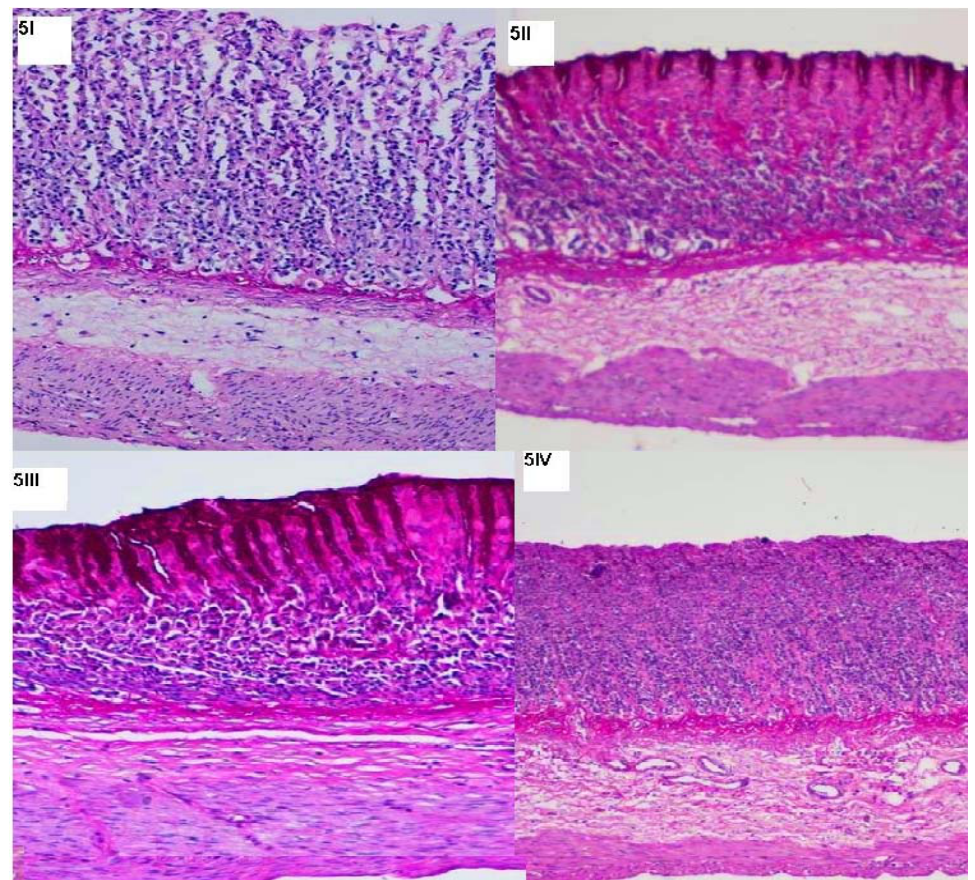
Figure 5. Effect of CuLBS on gastric tissue glycogen-PAS staining. Stomach subjected to ethanol-induced ulcer after treatment with CMC ( 5I ); CuLBS (30 mg/Kg) ( 5II ), CuLBS (60 mg/Kg) ( 5III ) and the normal rat stomach ( 5IV